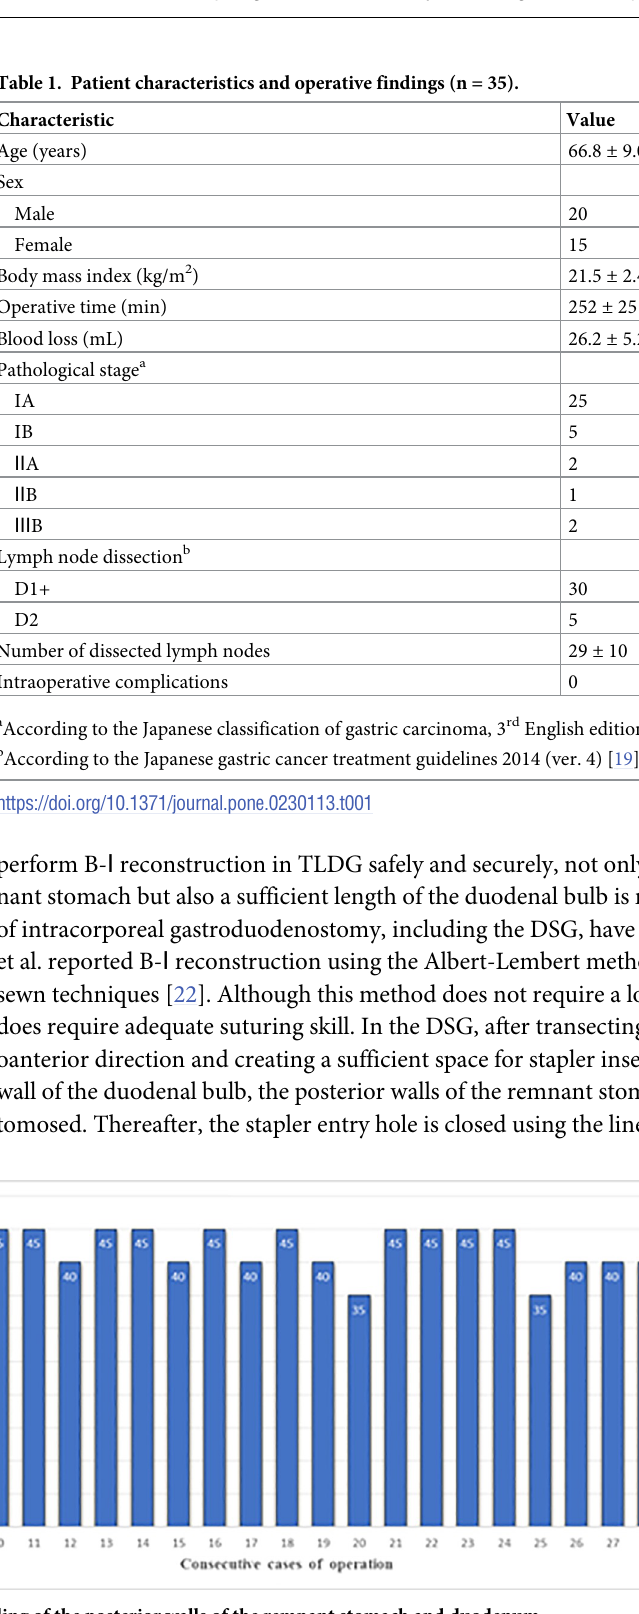
PLOS ONE | https://doi.org/10.1371/journal.pone.0230113 March 6,